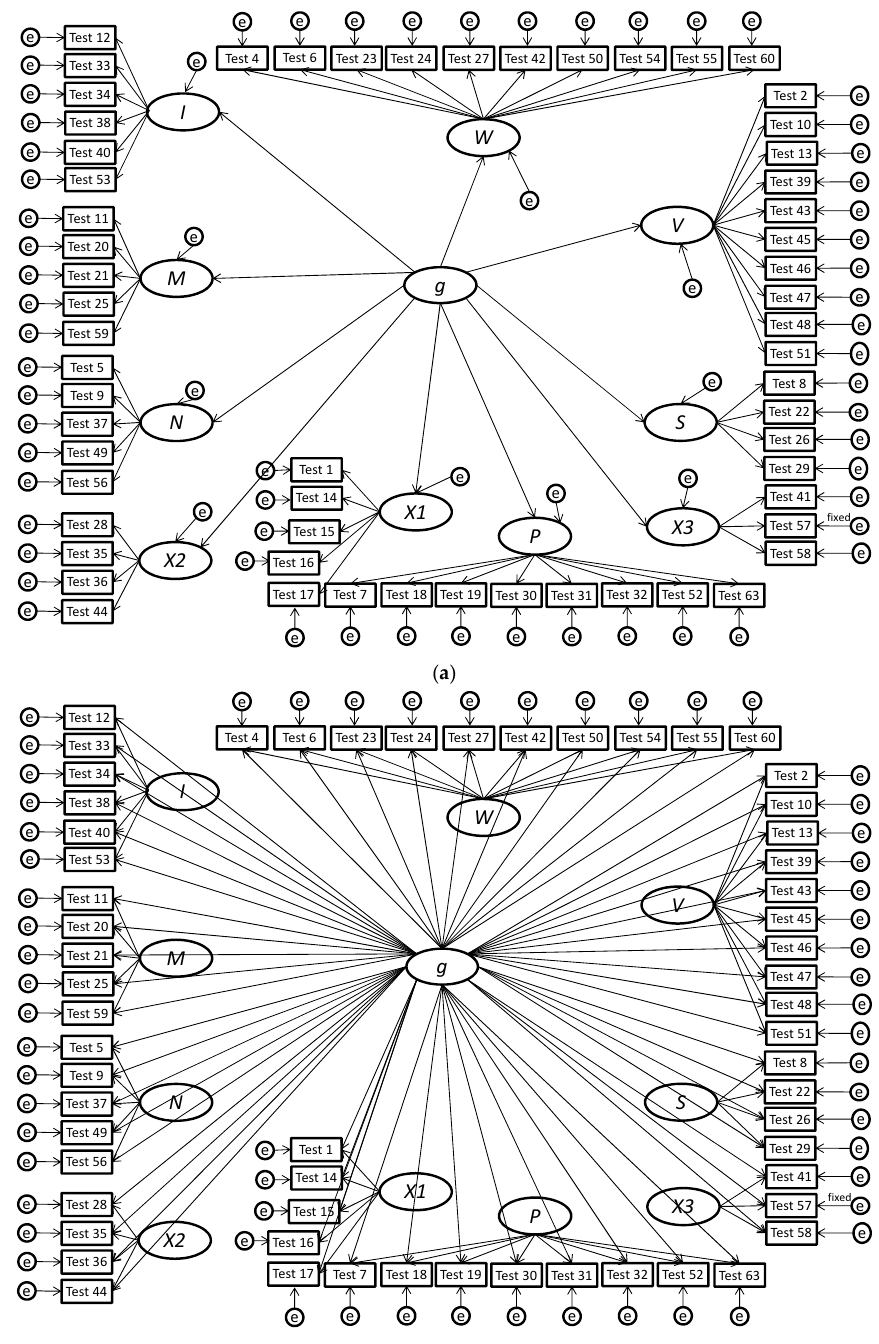
Figure 1. ( a ) This figure shows the higher-order model for the Thurstone and Thurstone [8] test battery. For the sake of clarity, only primary loadings are depicted. The model that only included primary loadings had an RMSEA of 0.063, an AIC of 6696, and a χ 2 of 6438 ( df = 1,701, p < 0.001). Due to a Heywood case, the error variance for Test 57 was fixed to the value implied by its reliability; ( b ) This figure presents the corresponding bifactor model for the Thurstone and Thurstone [8] test battery. This model, which only had primary loadings, had an RMSEA of 0.059, an AIC of 6093, and a χ 2 of 5737 ( df = 1652, p < 0.001). A ∆ χ 2 of 701 ( df = 49, p < 0.001) indicated that it had statistically significant incremental fit over the higher-order model. Due to a Heywood case, the error variance for Test 57 was fixed to the value implied by its reliability.